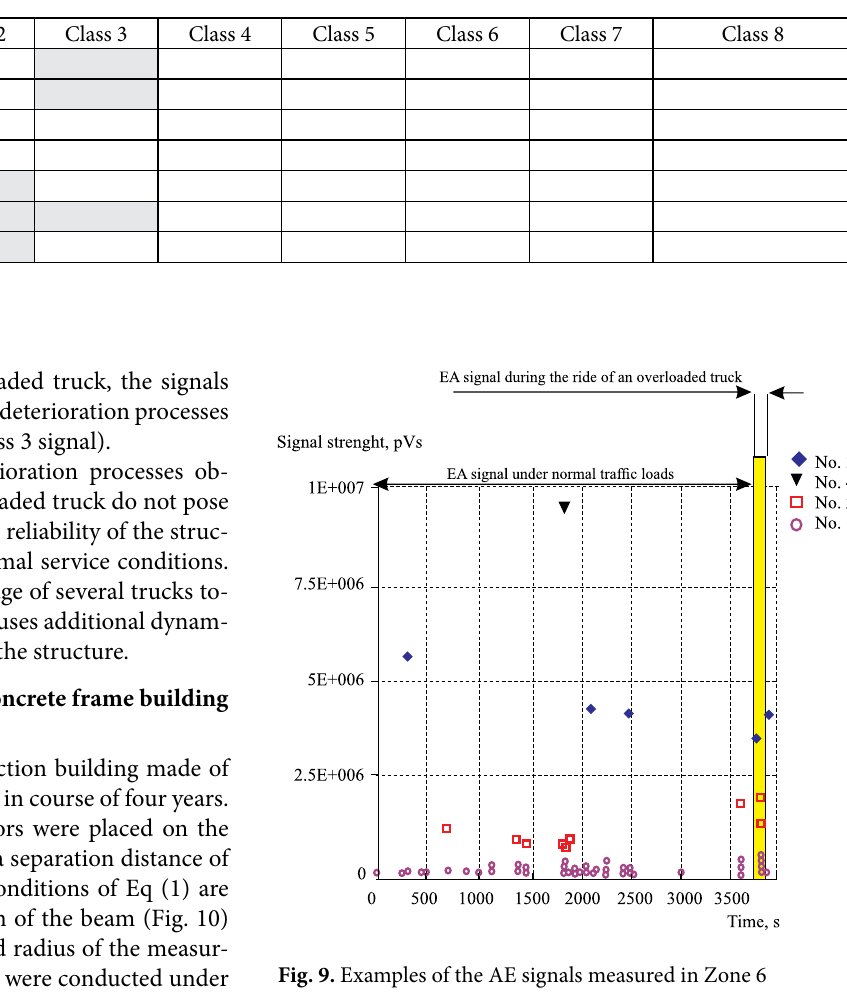
Table 4. Classes of signals (damage processes) registered in different measuring zones of one of the bridge beams during the ride of an overloaded truck